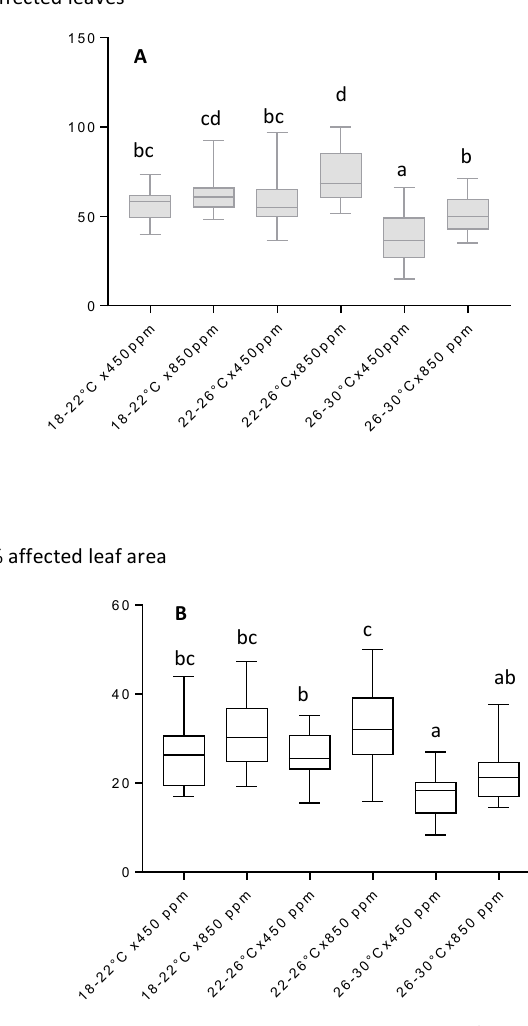
Figure 3. Effects of different CO 2 and temperature (18–22, 22–26 and 26–30°C) combinations on leaf spot caused by Allophoma tropica on lettuce (cv. Elisa). A) Mean disease incidence, % of affected leaves. B) disease severity, % of leaf area affected. Mean values for trials 4–6. Data accom- panied by the same letter are not significantly different, according to Tukey’s Test ( P <0.05). The boxes represent the interquartile ranges (IQR) between the first and third quartiles, and the lines inside the boxes represent the me- dian (2nd quartile). The whiskers denote the least and the greatest values within 1.56 IQR from, respectively, the first and third